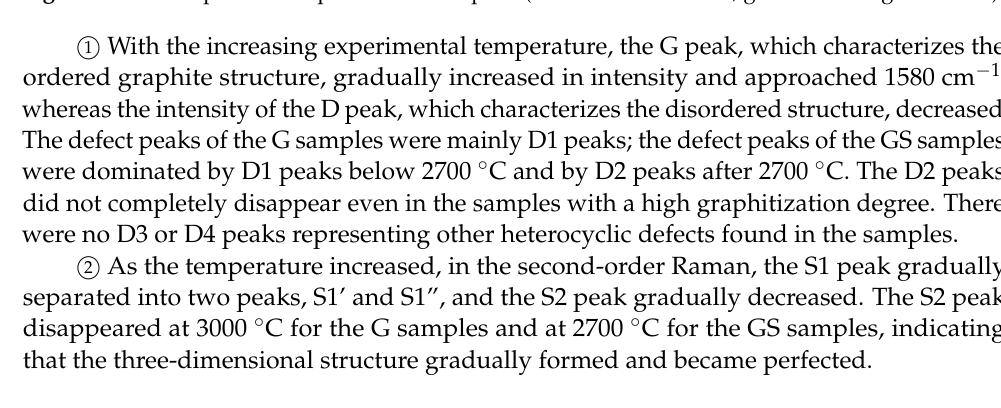
Figure 2. Raman spectra of experimental samples. (red line: fitted curve; green line: original